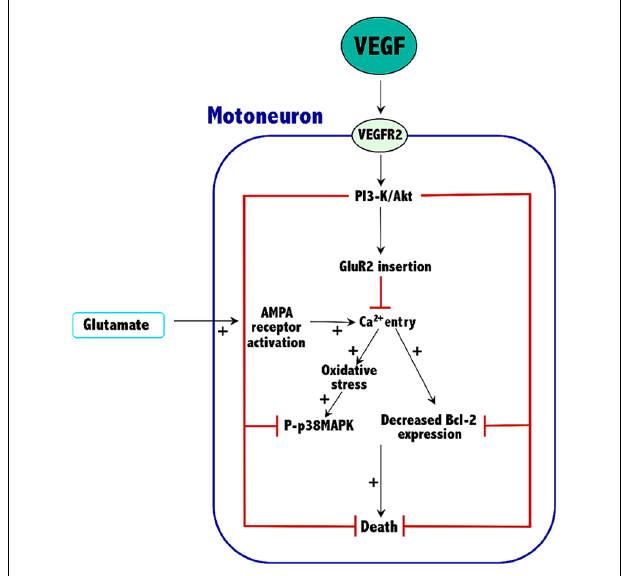
FIGURE 1 | Mechanisms involved in the neuroprotective effects of VEGF against excitotoxicity in spinal cord motoneurons. The plus symbols ( + ) indicate the signaling pathways that are potentiated by excitotoxicity. See Section “Conclusion” for further